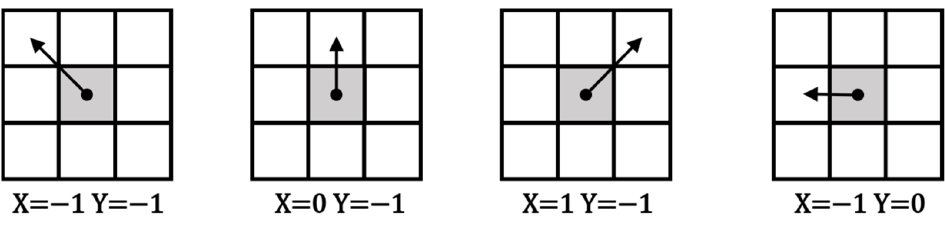
Figure 4. Direction measure of GLCM calculation in this study.